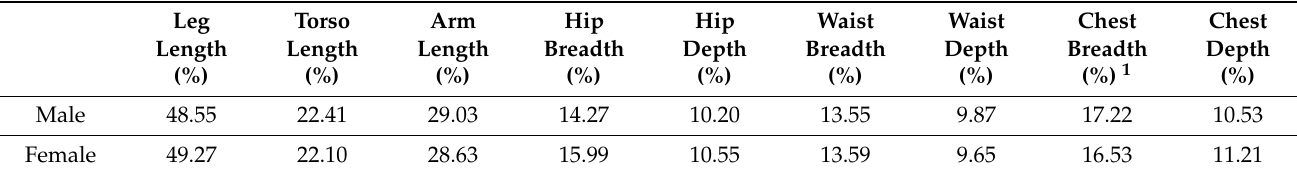
Table 1. Average Human Anthropometric Proportions (Percentage of Total Streamline Length) (From [23,24]).